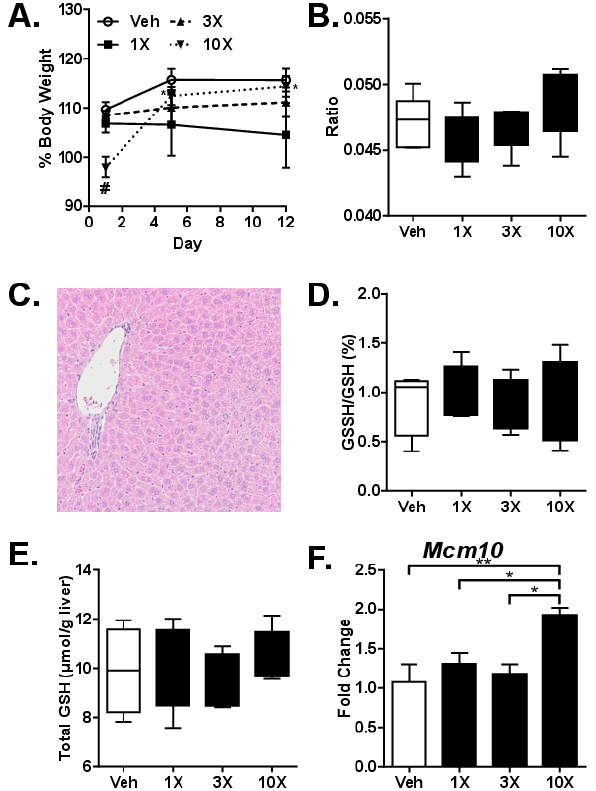
Figure 2. Analysis of dGTE sub ‐ acute toxicity. Body weights (( A ) # significant compared to vehicle, *significantly different from Day 1 within a dose group) and liver ‐ to ‐ body weight ratio ( B ). Photomicrograph of intact liver after gavaging mouse with 10X MED dGTE for 2 weeks ( C ). GSSH/GSH ratio ( D ), total glutathione ( E ) and mRNA levels of Mcm10 gene ( F ).* p < 0.05, ** p < 0.01; # p < 0.05 compared to vehicle ( F ); mean +/ - SEM ( n = 5 per group).